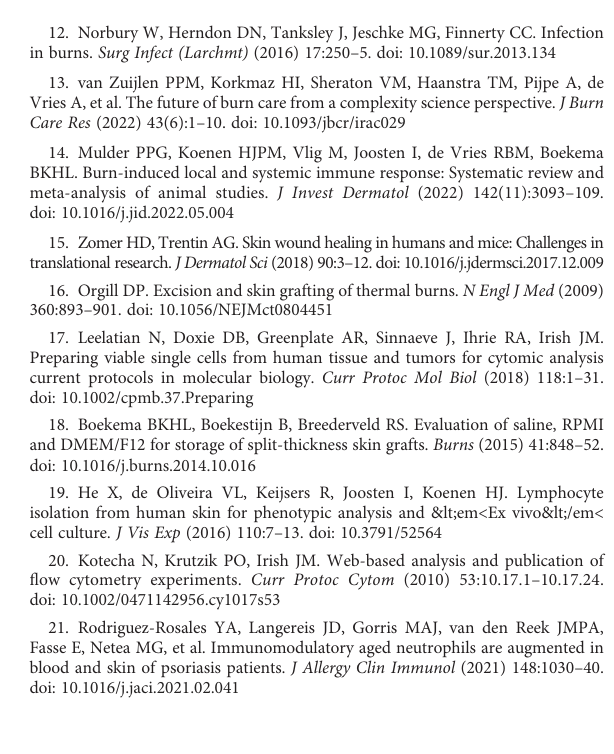
SUPPLEMENTARY FIGURE 1 Gating strategy of fl ow cytometric analysis. At the top of the plots the panel numbers are shown for which the gating was performed (P1, 2, 3 and 4). SUPPLEMENTARY FIGURE 2 Cell counts in burn tissue. Flow cytometry-based quanti fi cation of: (A) Percentage of leukocytes that stained negative for 7-AAD or propidium iodide (viable cells); (B) Percentage of isolated cells that is CD45- ( fi broblasts, keratinocytes, endothelial cells, others); (C) Number of eosinophils (CD9 + CD16 - granulocytes) per mg tissue; (D) Percentage of macrophages that is positive for CD40, CD80, CD163 or CD206; (E) Percentage of T cells that are CD4 - and CD4 + . (F) Number of gd T cells ( gd TCR + ) per mg tissue; (G) Percentage of NK cells (CD56 + lymphocytes) within leukocyte population; (H) Percentage of B cells (CD19 + lymphocytes) within leukocyte population. P values were calculated using Mann-Whitney U statistical tests, signi fi cant differences are indicated by black asterisks: *p < 0.05; **p < 0.01; ***p < 0.001. SUPPLEMENTARY FIGURE 3 Concentrations of soluble factors in burn tissue. Healthy skin was used as controls. Black lines show mean values and the black striped line represents the lowest limit of detection. P values were calculated using Mann-Whitney U statistical tests, signi fi cant differences are indicated by black asterisks: *p < 0.05; **p < 0.01; ***p <